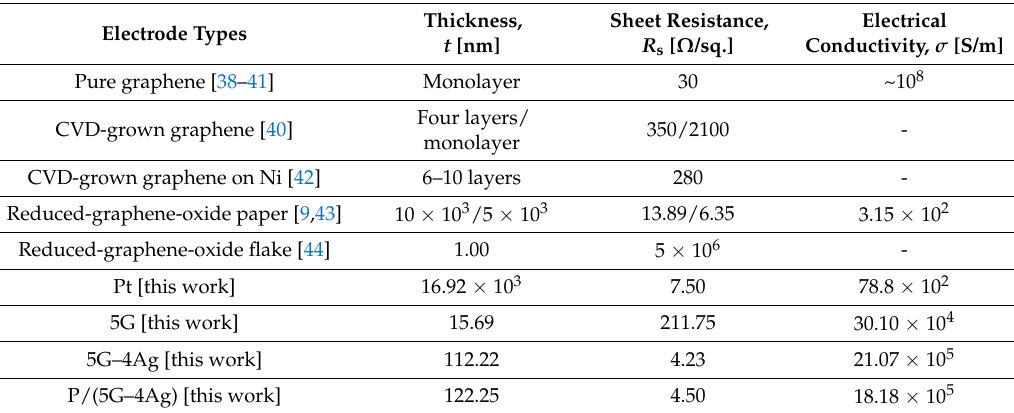
Table 1. Thickness, sheet resistance and electrical conductivity of various types of electrode. Electrode Types Electrode